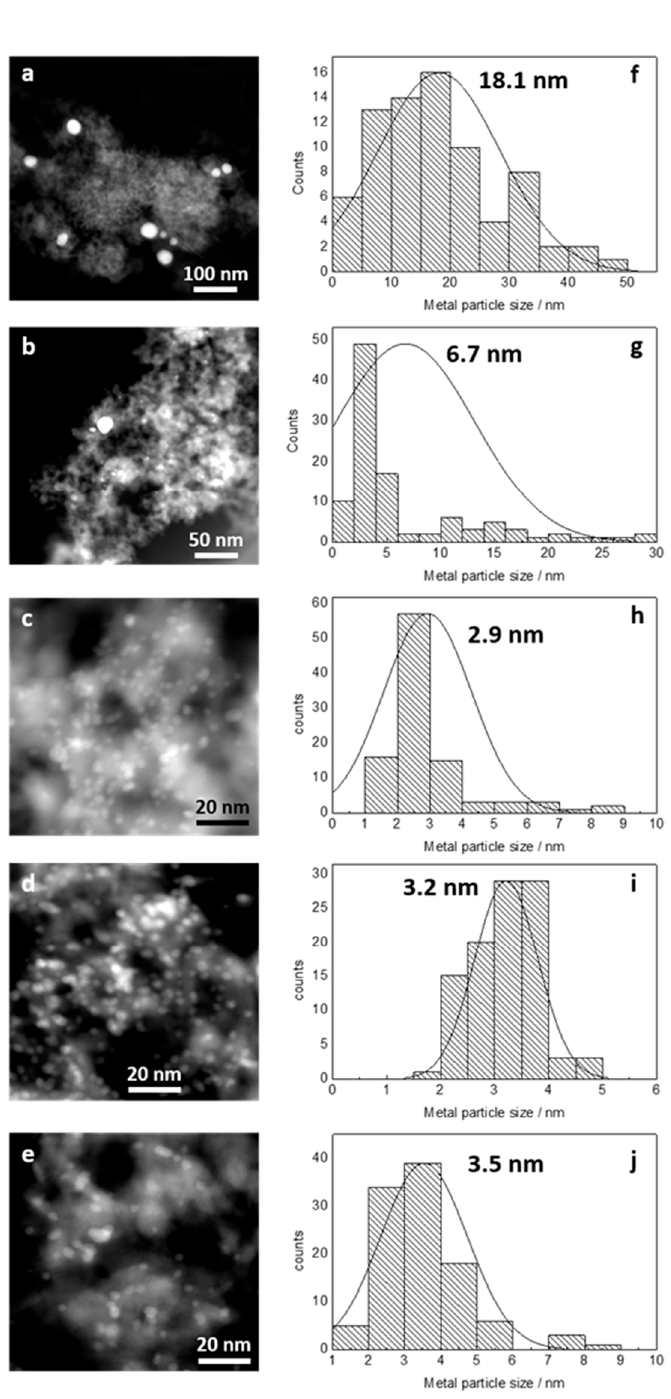
Figure 2. Scanning transmission electron microscopy (STEM) images of di ff erent catalysts: ( a ) Au / Al 2 O 3 , ( b ) AuRh(3:1) / Al 2 O 3 , ( c ) AuRh(1:1) / Al 2 O 3 , ( d ) AuRh(1:3) / Al 2 O 3 , and ( e ) Rh / Al 2 O 3 catalysts. Particle size distributions of di ff erent catalysts: ( f ) Au / Al 2 O 3 , ( g ) AuRh(3:1) / Al 2 O 3 , ( h ) AuRh(1:1) / Al 2 O 3 , ( i ) AuRh(1:3) / Al 2 O 3 , and ( j ) Rh / Al 2 O 3 catalysts. The average particle sizes of the catalysts are indicated in the histograms.